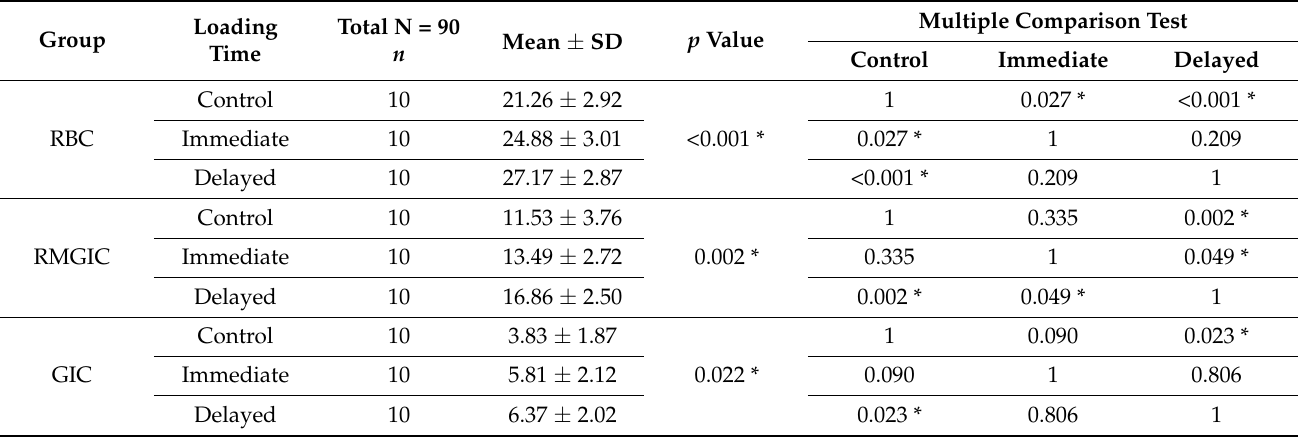
Table 3. The mean and standard deviation (SD) values of the microtensile bond strength in megapas- cal (MPa) based on loading time of each